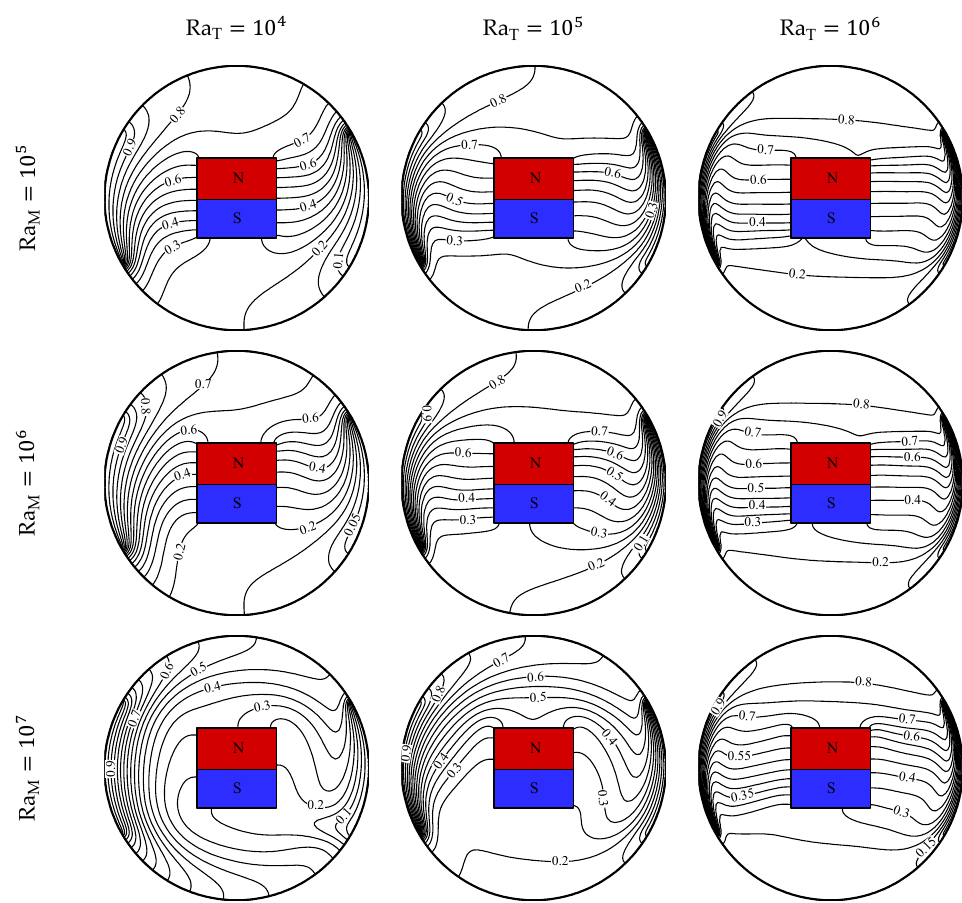
Figure 9. Dependence of the isotherms on the Ra T and, Ra M when n = 0.8, λ = 0, Pr = 100, Ma = 10 − 4 , β c = 60, δ = 30 ◦ and L = 0.3. Table 2. Dependency of the average Nusselt number on the Ra T and Ra M when n = 0.8, λ = 0, Pr = 100, β c = 60, δ = 30 ◦ and L =